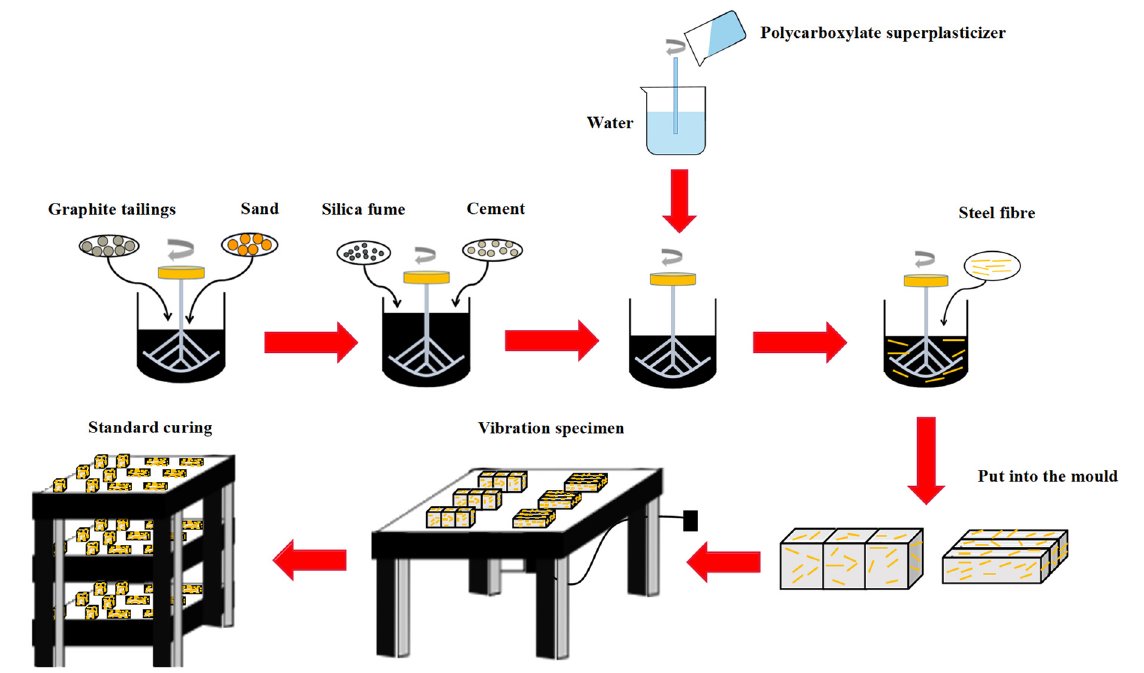
Figure 4. Preparation process of GT ecological concrete.